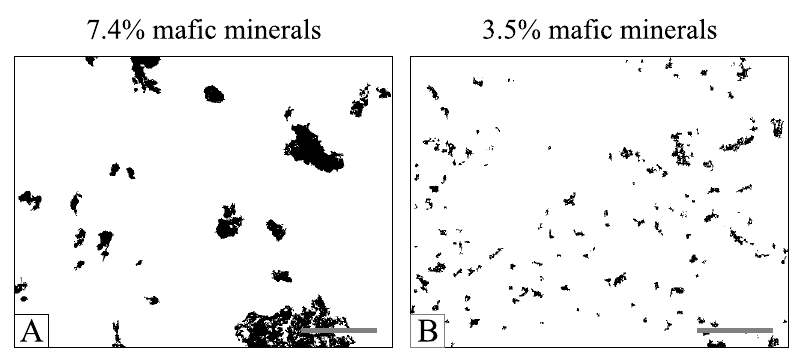
Fig. 4 – Binary (black and white) image generated by threshold of unaltered samples A (A) (cid:1) software after selective staining. Black corresponds to and B (B) using Adobe Photoshop mafic minerals (amphibole and biotite) contents in each sample. Scale bars are 0.5 cm